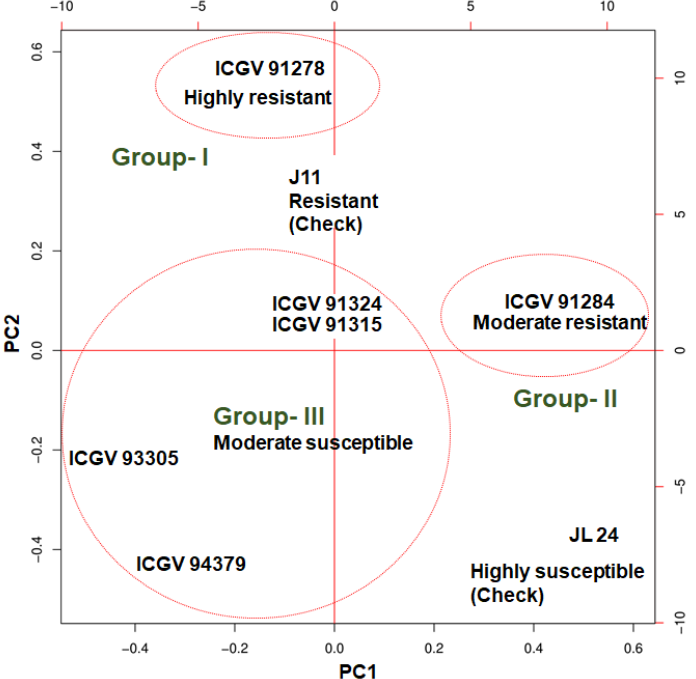
Figure 2. Principal component analysis depicting correlation among samples based on gene ex- pression data. Group 1 (ICGV 91278), highly resistant, group 2 (ICGV 91284) moderately resistant, group 3 (ICGV 91324, ICGV 91315, ICGV 93305, ICGV 94379), moderately susceptible, in compari- son to highly susceptible check JL24.